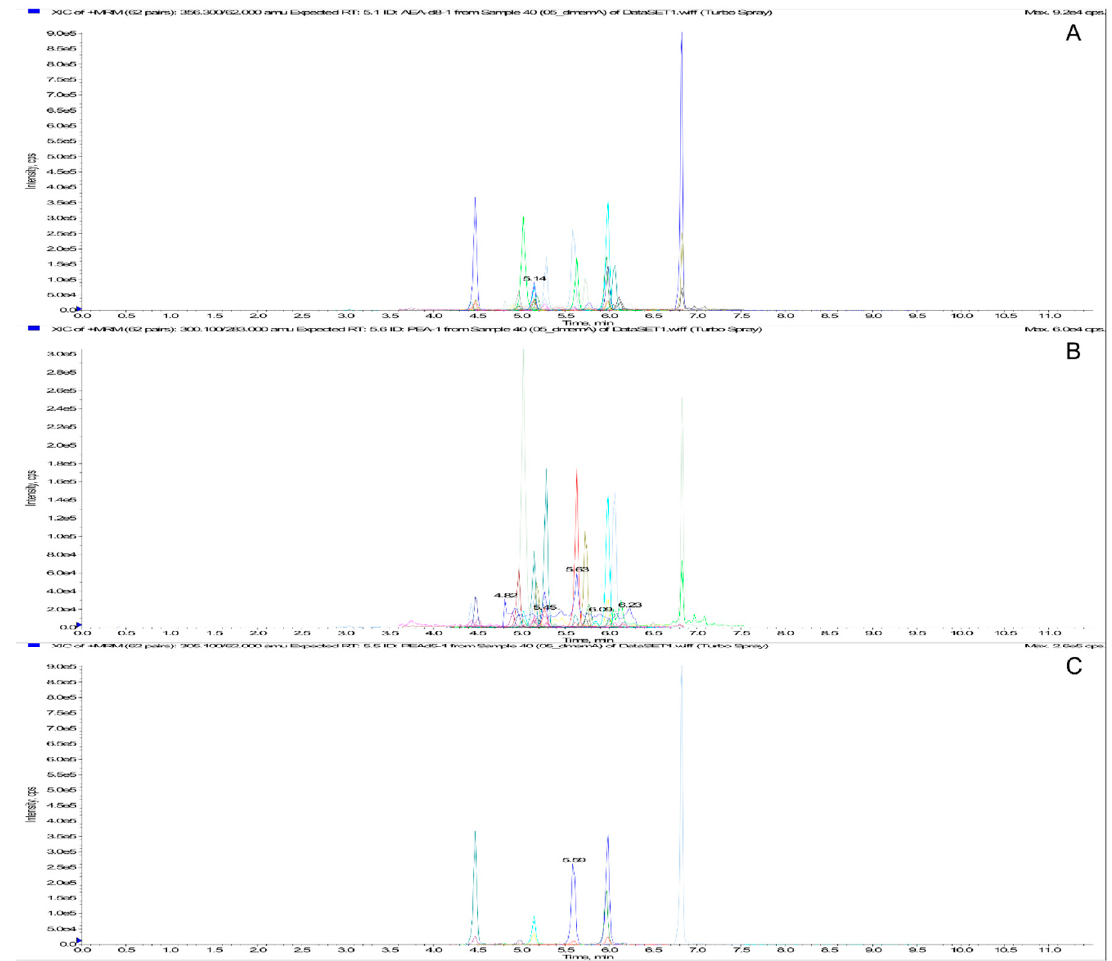
Figure 3. MRM chromatogram of ECs / NAEs extract. From the top: Total ion Current ( A ), standard extraction (0.5 ng / mL) ( B ), and ISs extraction ( C ).